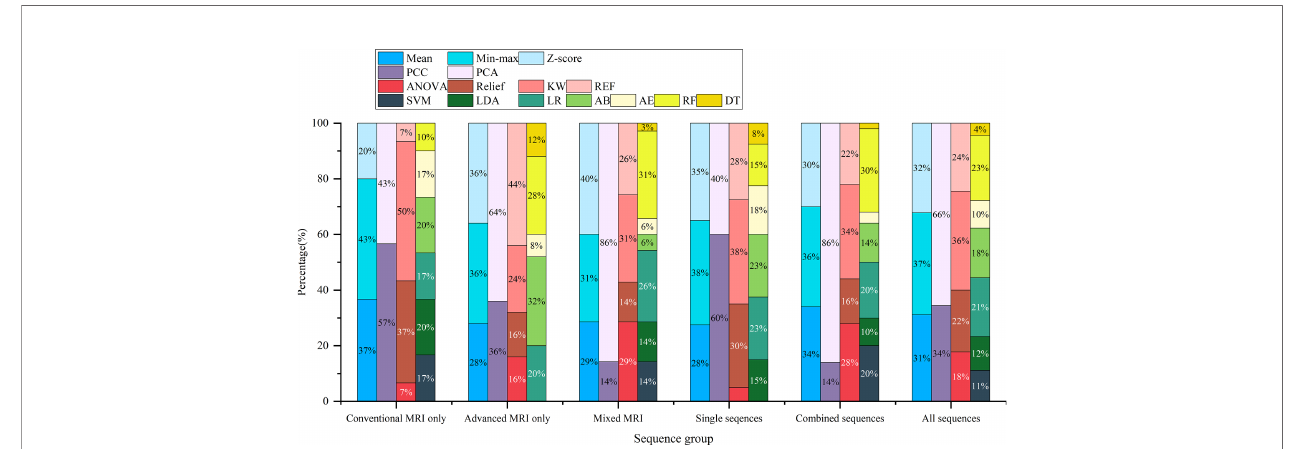
FIGURE 6 | The percentage of machine learning techniques in 90 top- fi ve-performing models of different model categories. “ Conventional MRI only ” represents models developed only with conventional MRI sequences; “ Advanced MRI only ” for models only with advanced MRI sequences; “ Mixed MRI ” for models with both conventional and advanced MRI sequences; “ Single sequences ” for models with one sequence; “ combined sequences ” for models with at least two sequences; and “ All sequences ” for models of all sequence